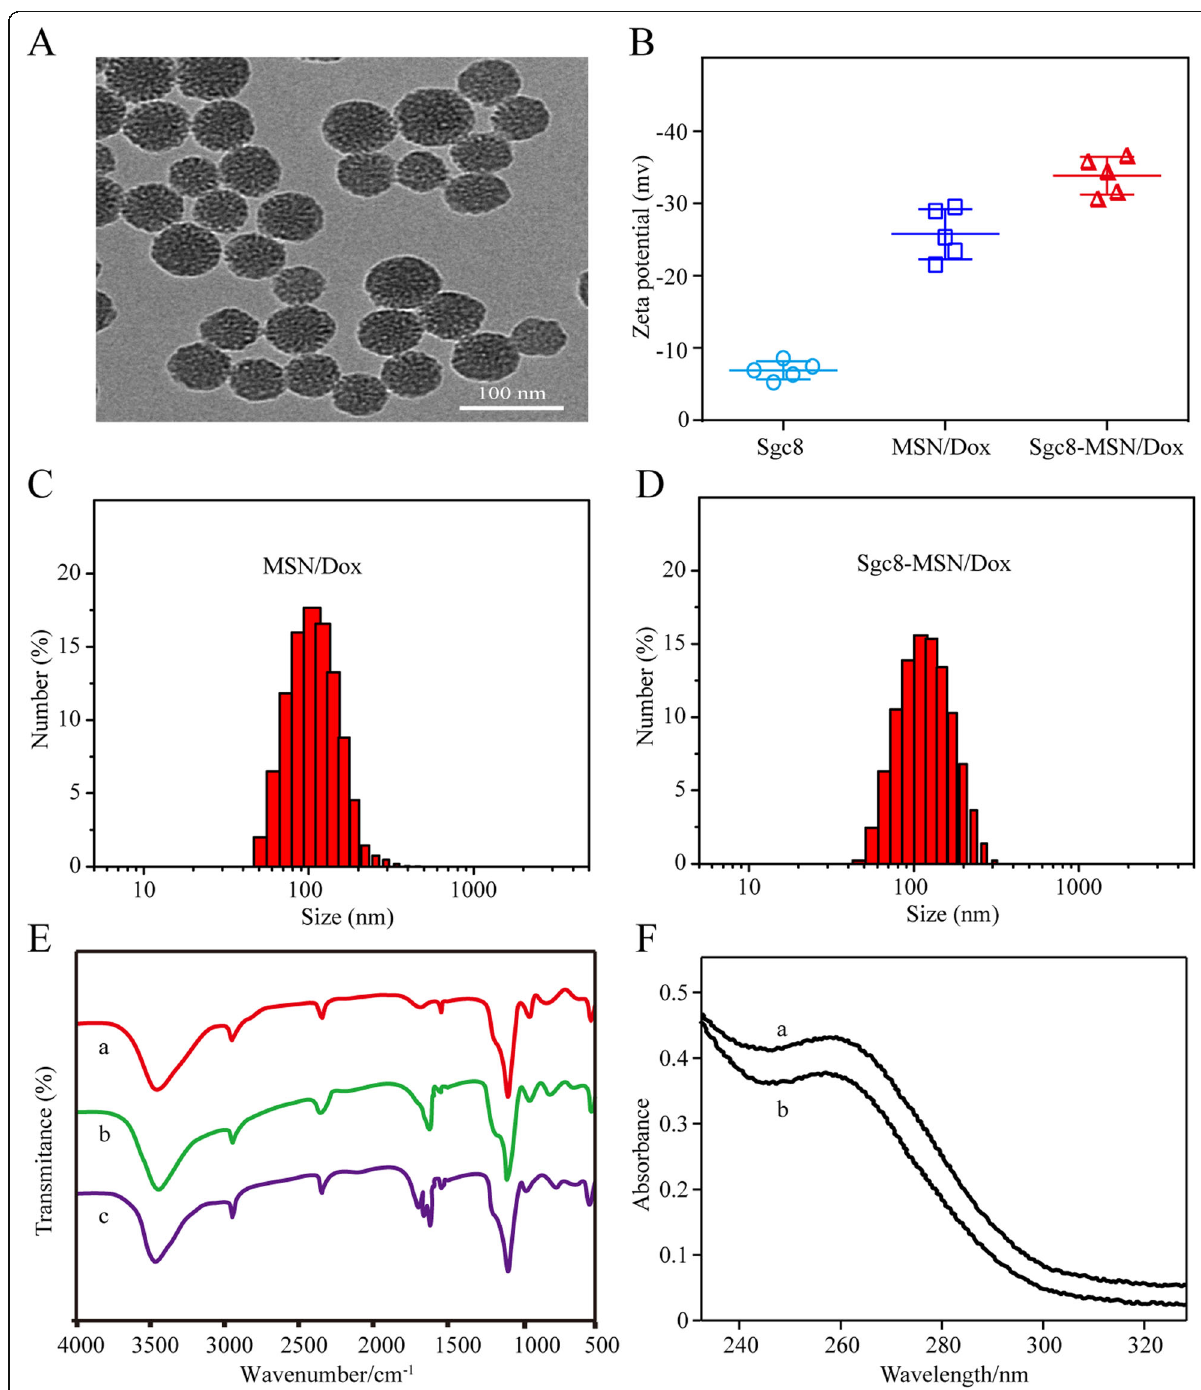
Fig. 3 Characterization of nanomaterials. a Electron micrograph of Sgc8-MSN/Dox. b Potential diagram of nanoparticles. Particle size distribution of c MSN/Dox and d Sgc8-MSN/Dox. e FT-IR spectra of nanomaterials: a MSN, b MSN/Dox, and c Sgc8-MSN/Dox. f UV – Vis spectra of a Sgc8 aptamer solution, b washing supernatant in the process of preparation